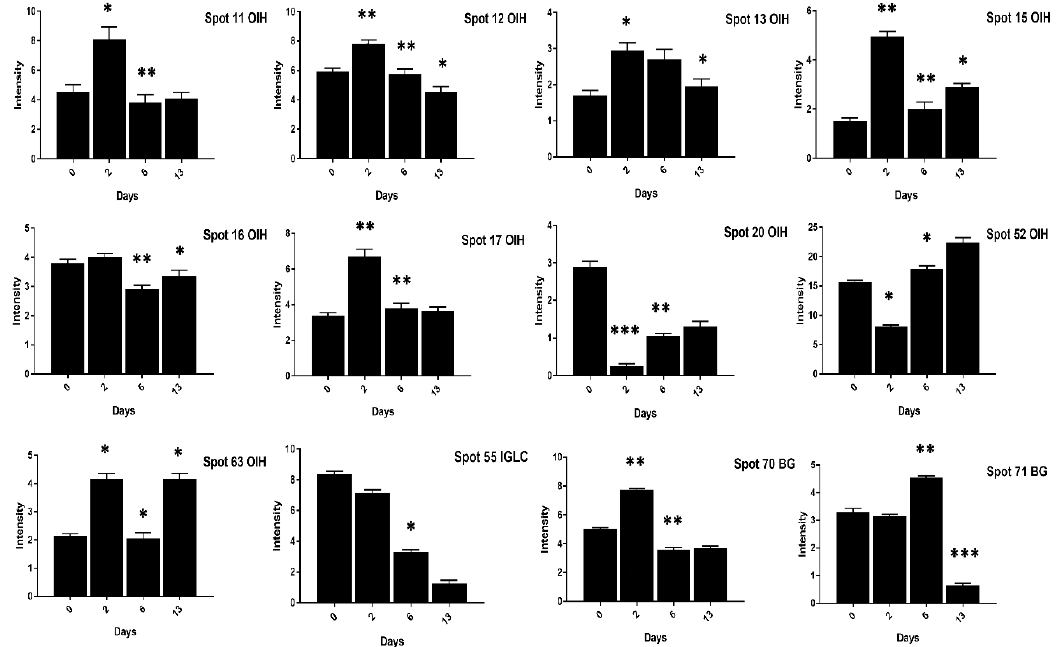
Figure 9. Differential expression of OIH, IGLC, and BG proteins after 0, 2, 6, and 13 days of incubation was shown in high cholesterol eggs. The column profiles of OIH (11–13, 15–17, 20, 52, 63), IGLC (55), and BG (70, 71) are shown as bar charts with significant differences. The values are from three independent replicates and the error bars represent the standard deviation. * p < 0.05, ** p < 0.005, *** p < 0.0001.